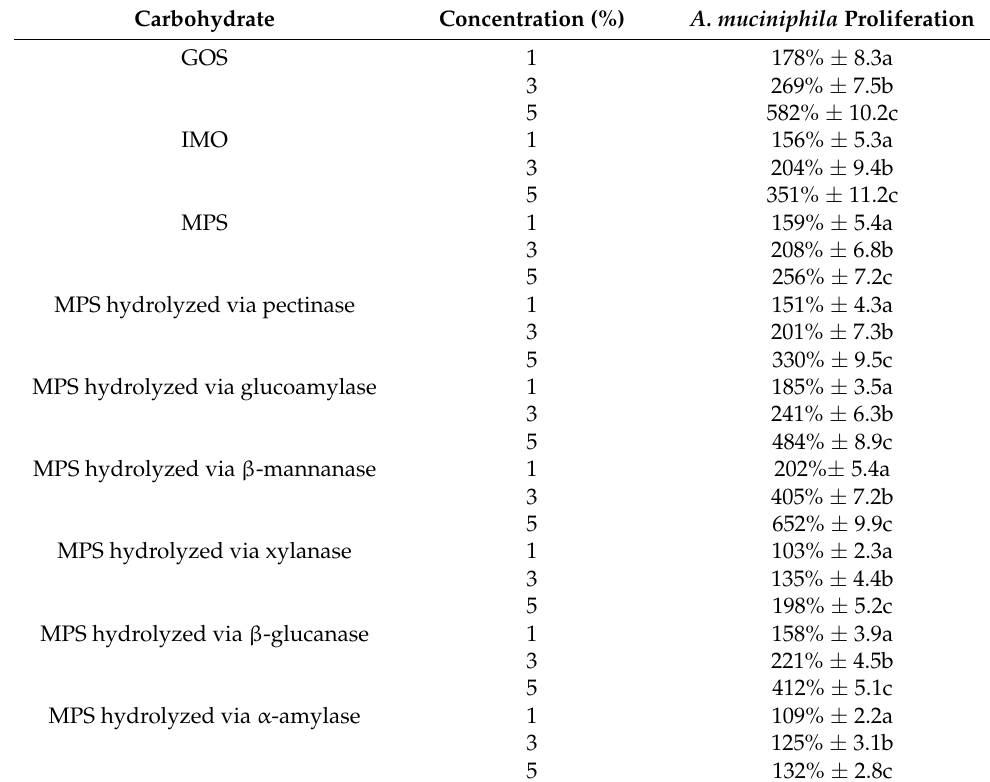
Table 2. Proliferation of A. muciniphila cultured in medium containing different prebiotic carbohy- drates after 5 days of incubation at 37 ◦